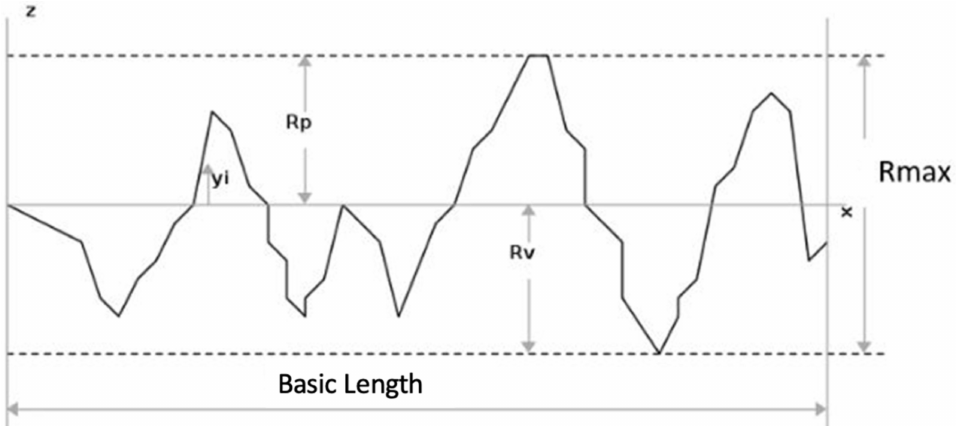
Figure 3. Graph depicting the main parameter, Rmax; basic length, L, for calculating roughness values. Z axis represent the height dimension of a surface, x represent the length